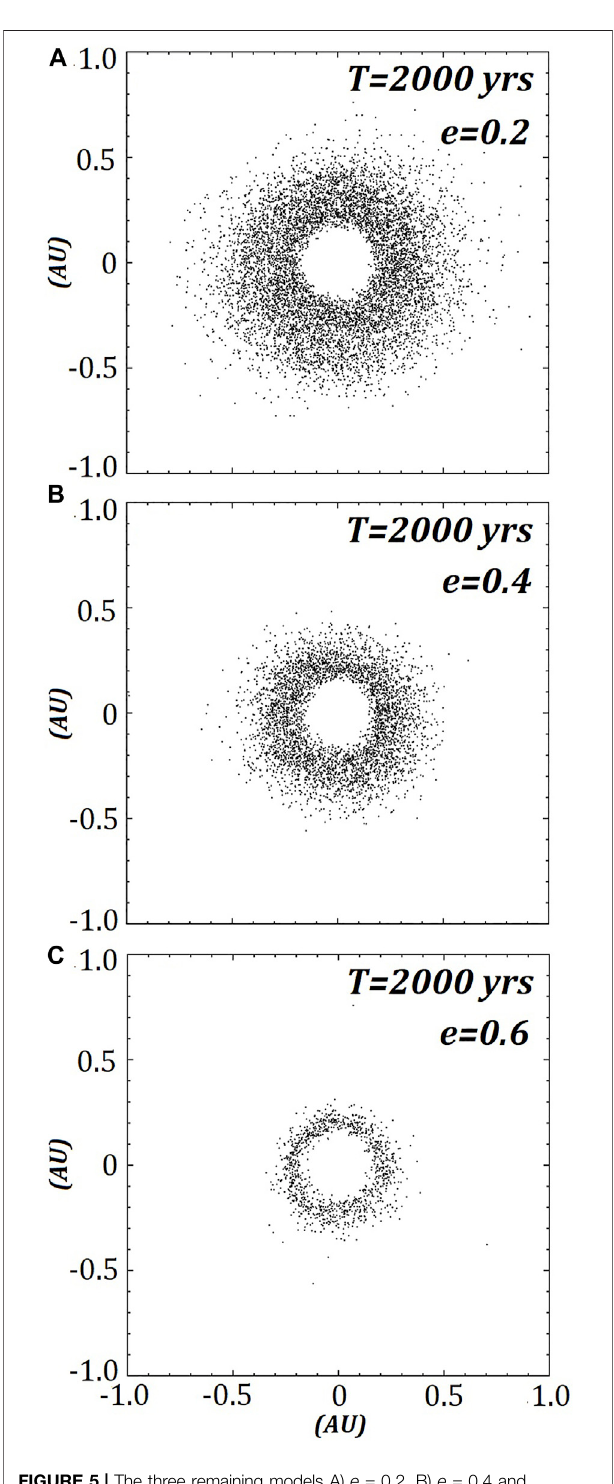
FIGURE 5 | The three remaining models A) e = 0.2, B) e = 0.4 and C) e = 0.6 of a retrograde ring around J1407b (M = 20MJ) after 2000 years or ~182 complete orbits about the